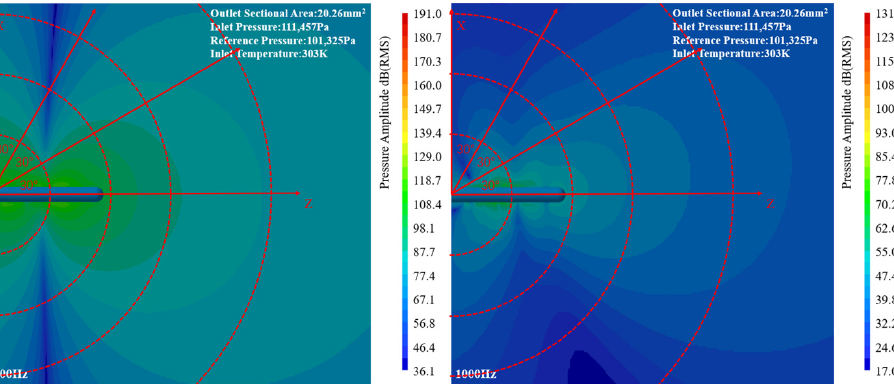
Figure 26. Nephograms of the 2000 Hz and 3000 Hz far-field sound pressure levels of equal-diameter nozzles.